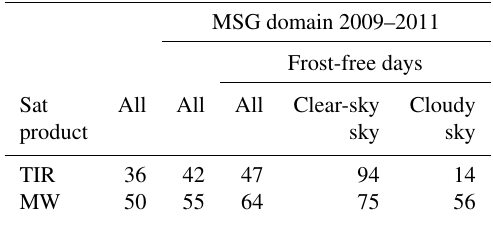
Table 2. Percentage coverage for two LST products. Table 3. Summary of “clear-sky” validation